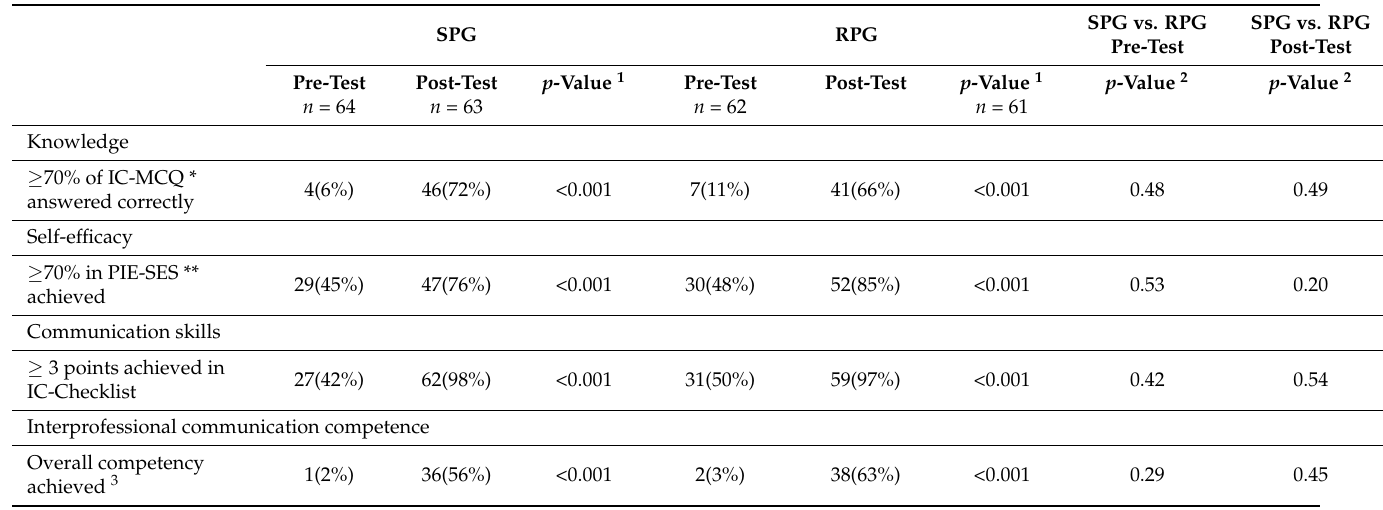
Table 3. Counts (proportions) of dichotomous interprofessional communication competency parame- ters per group for pre-test and